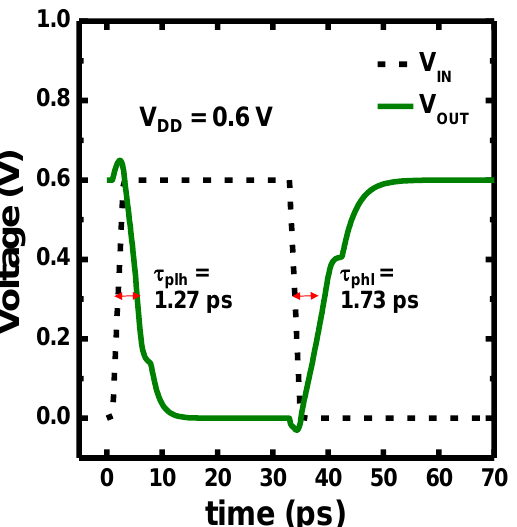
Figure 10. Transient response of the designed N1 CFET inverter with Si 0.7 Ge 0.3 PMOS and Si NMOS under a ~14 GHz operation.